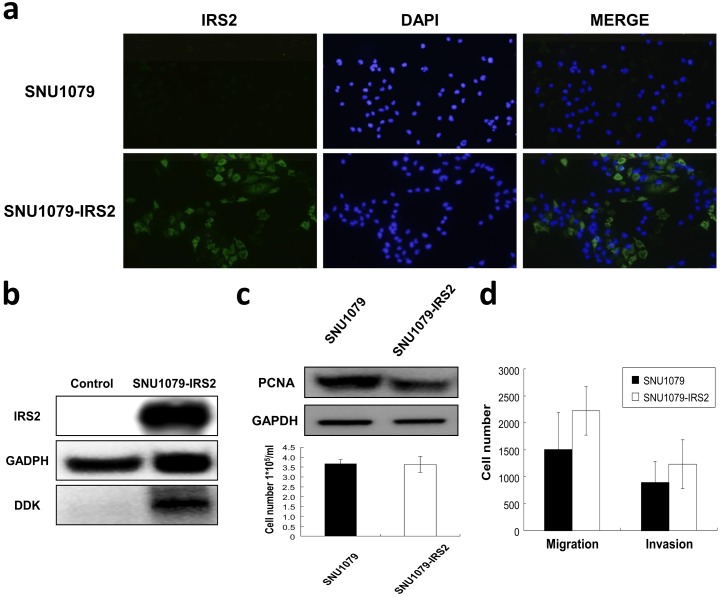
Enforced expression of IRS2 in iCCA cells.(a) SNU1079 cells were transiently transfected with expression vector (SNU1079-IRS2). After 48 hours, expression of IRS2 was determined by immunofluorescence detection of IRS2 protein (left panel, green) and DAPI (middle panel, blue). MERGE contains the combined image of both GFP and DAPI staining (right panel). Percentage of IRS2-positive SNU1079 cells was normalized to DAPI stained nuclei. Images were obtained at a magnification of × 100. (b) Total cell lysates were analyzed for IRS2 protein levels by Western blotting. Anti-DDK tag antibody was used to reveal the extent of IRS2 overexpression. (c) The effect of IRS2 overexpression on growth potential was determined by Western blotting using anti-PCNA antibody and manual counting of total cell numbers. (d) SNU1079-IRS2 cells were subjected to invasion and migration assays, and showed a greater degree of migration and invasion, compared with control cells. Graphs represent data from one of three independent experiments with similar results. Data represent means ± standard deviations for three independent experiments.